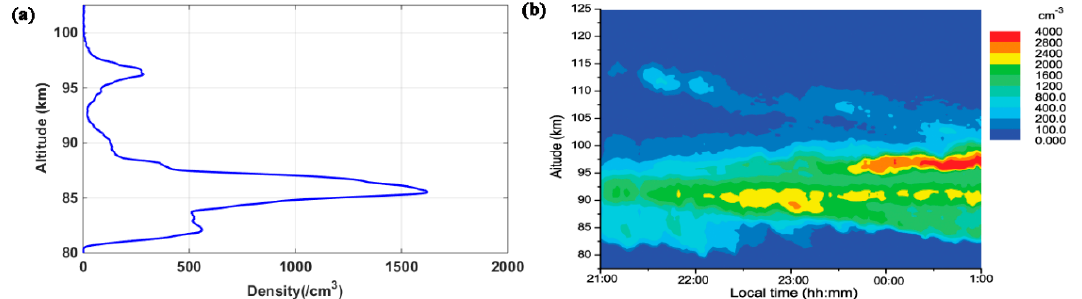
Figure 1. ( a ) The profile of the sodium density at 21:34 LT (Local Time) on 6 July 2010 and ( b ) the time-altitude variations of the sodium density from 21:00 LT on 6 July 2010 to 01:00 LT on 7 July 2010.